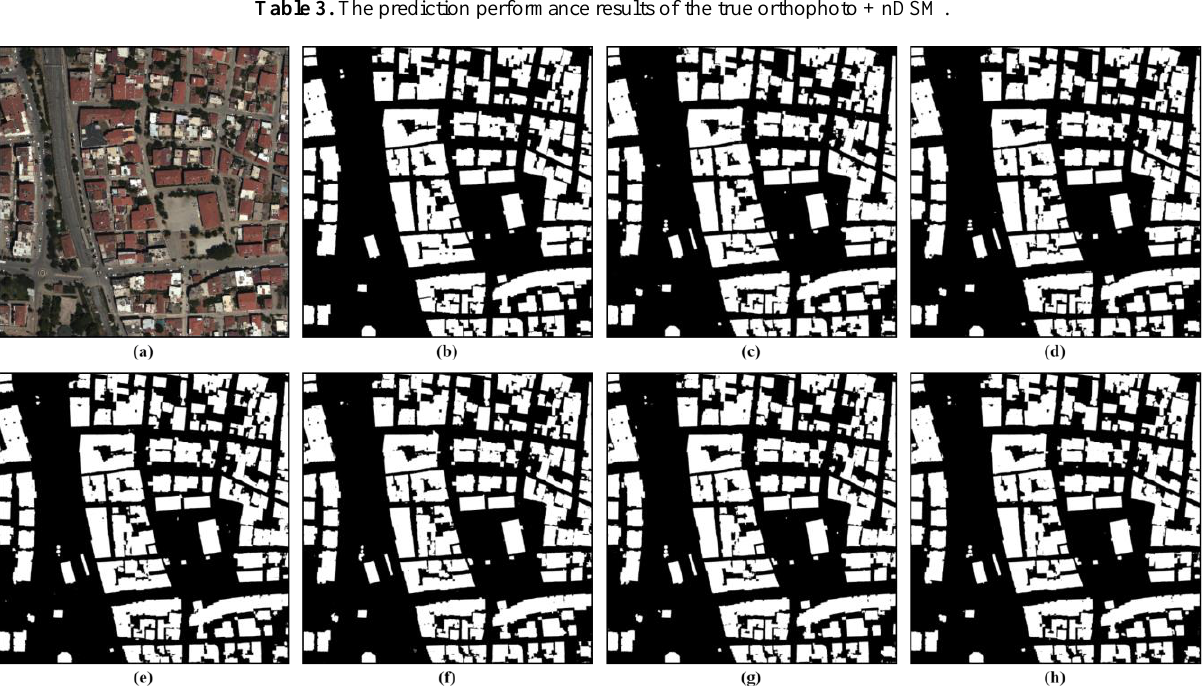
Table 3. The prediction performance results of the true orthophoto + nDSM.